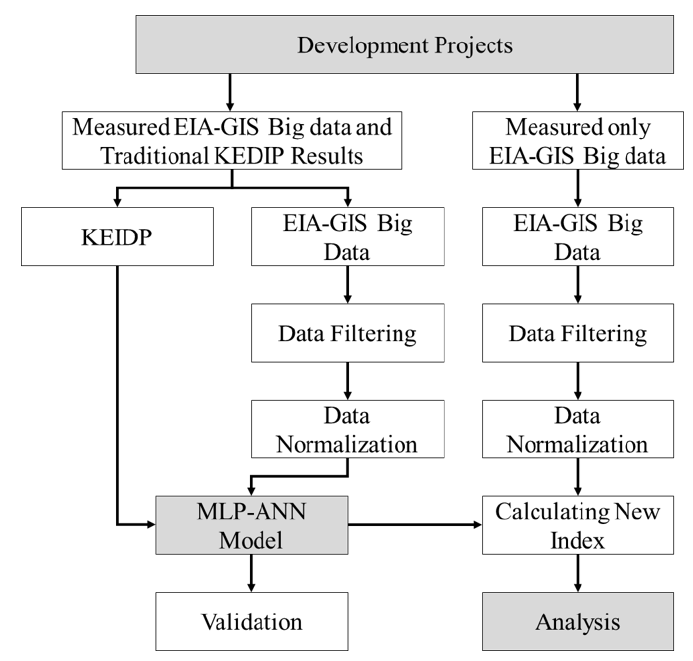
Figure 2. Research flow chart.